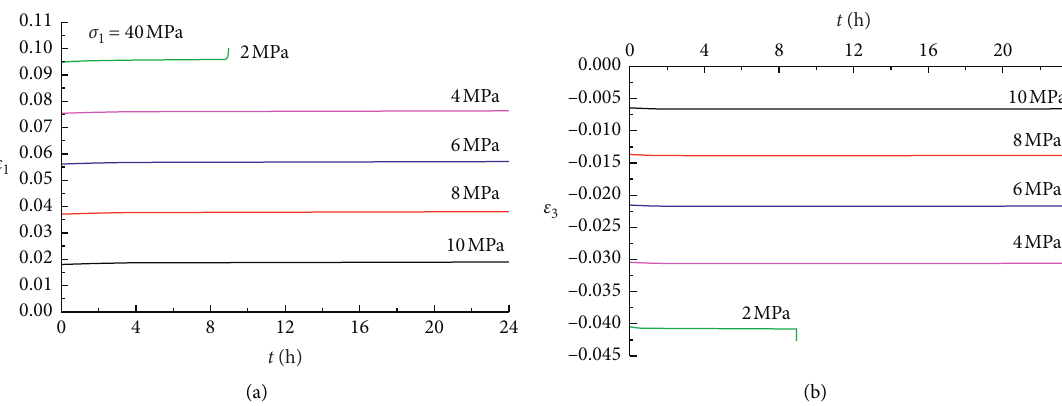
Figure 5: Unloading rheological curve cluster of coal samples with 30 ° fracture angle. (a) Cluster of axial creep curves. (b) Cluster of lateral creep